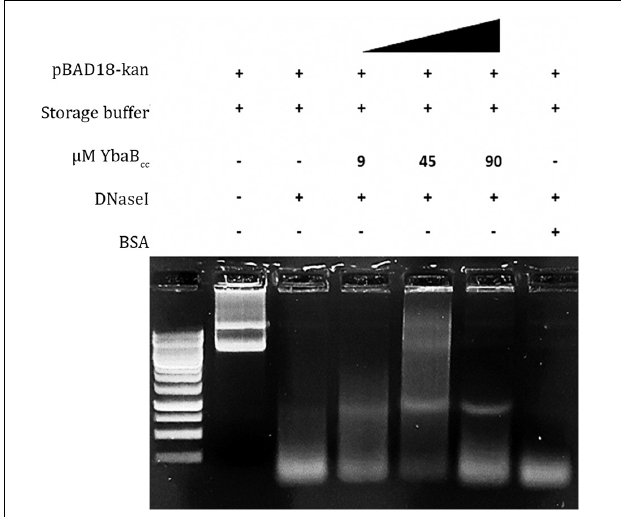
FIGURE 5 | YbaB Cc protects DNA from enzyme degradation. Different concentrations of YbaB Cc protein were incubated with supercoiled pBAD18 plasmid DNA, followed by treatment with DNase I restriction enzyme. Control reactions were incubated with BSA in place of YbaB Cc protein. YbaB Cc prevents complete plasmid DNA degradation by the enzyme as opposed to the BSA control reaction, where DNase I is able to degrade the plasmid completely. Thus indicating that YbaB Cc protein-bound plasmid DNA was protected by the degradative action of DNase I restriction enzyme and BSA could not protect the plasmid DNA from being degraded as it does not have DNA-binding